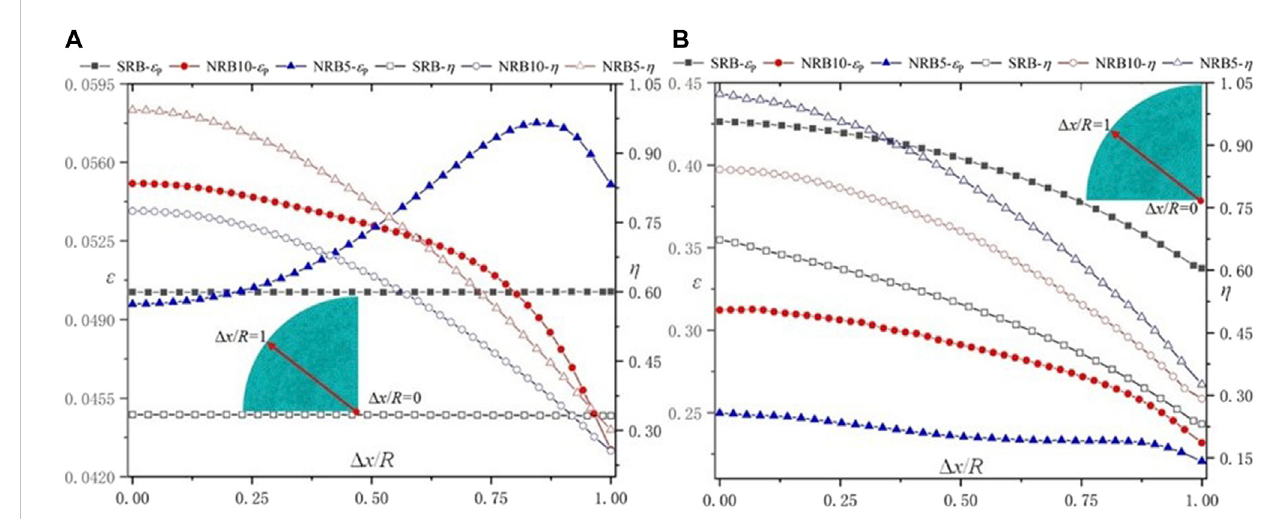
FIGURE 9 Distributions of stress triaxiality and equivalent plastic strain for round bar specimens: (A) the initiation of damage, (B) the initiation of crack.